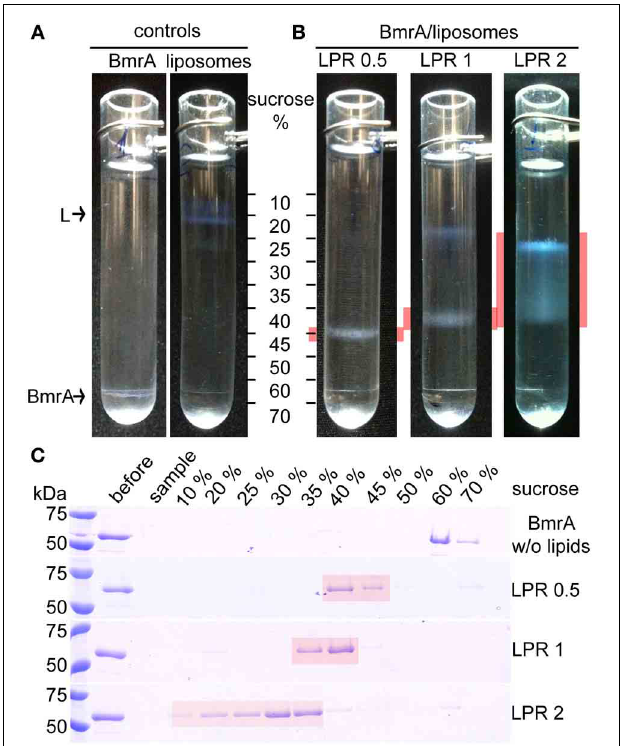
FIGURE 4 | Analysis of BmrA reconstitution in B. subtilis lipids with different LPRs by sucrose gradient centrifugation. (A) Controls: Sucrose gradients of BmrA dialyzed in the absence of lipids in order to identify the densities of aggregated BmrA (left) and of lipids without protein (right, labeled by an “L”). (B) Sucrose gradients of BmrA reconstituted in B. subtilis lipids using LPR 0.5, 1 and 2. Gradient layers containing BmrA in lipids are highlighted in red. (C) The layers ( ∼ 200 μ l) of the gradients were analyzed by SDS-PAGE. The first two lanes after the protein ladder show the sample before centrifugation (before) and the sample-layer (sample) after centrifugation. Given concentrations correspond to sucrose concentrations before